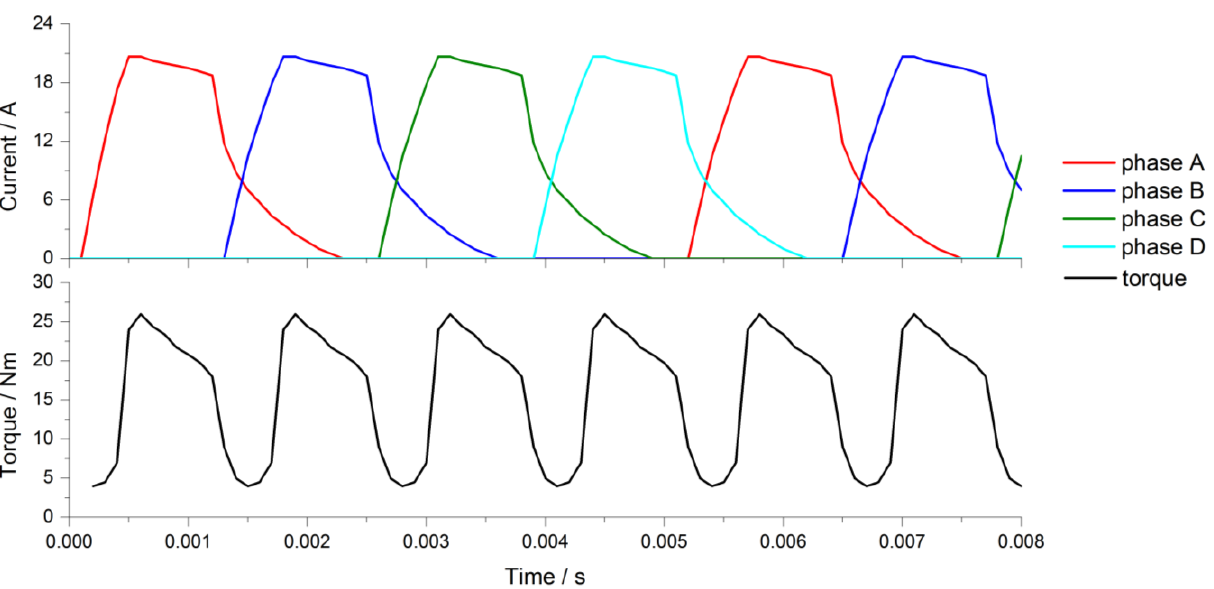
Figure 13. The current and torque waveforms of outer motor.